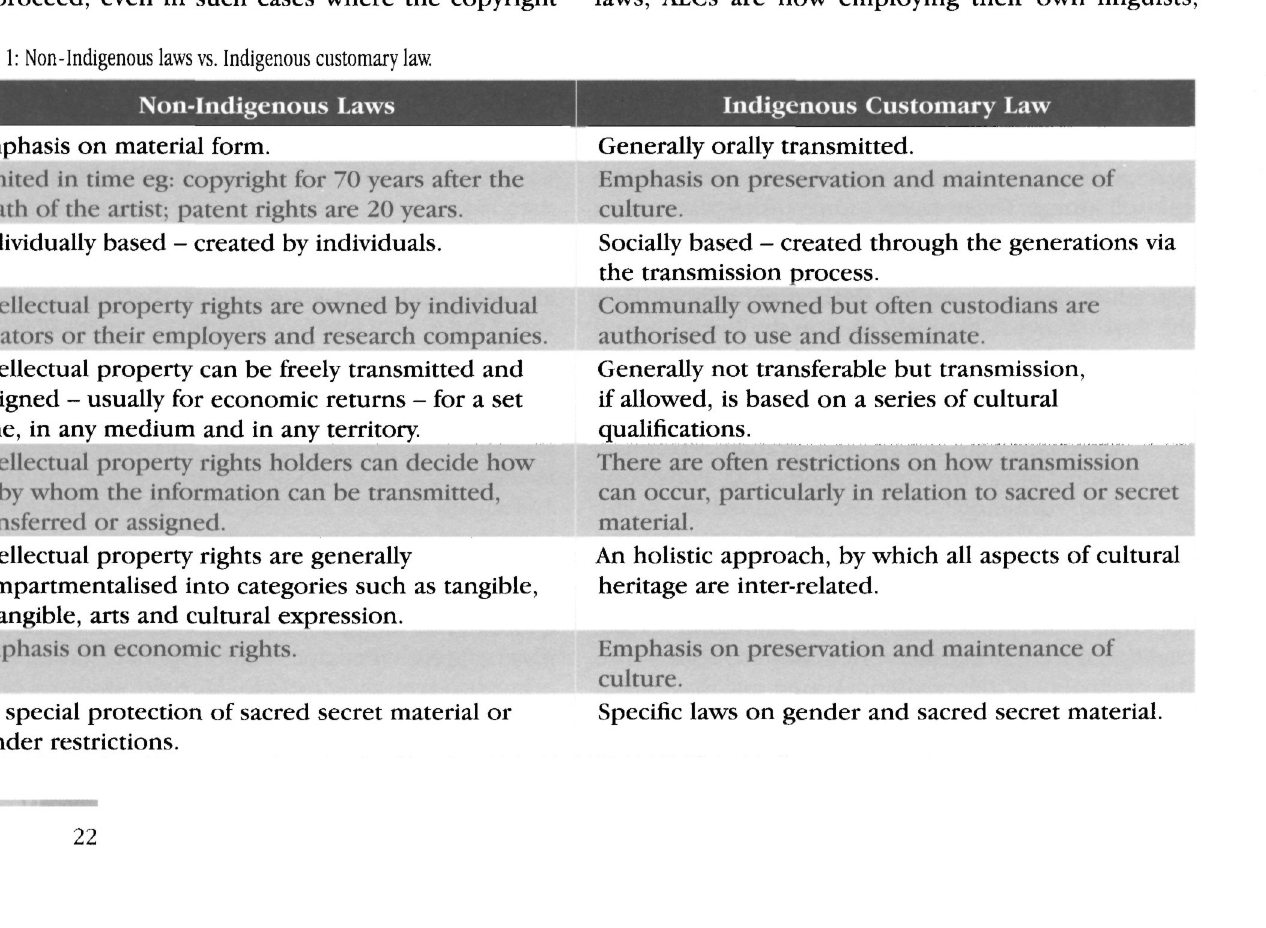
Table 1: Non-Indigenous laws vs. Indigenous customary